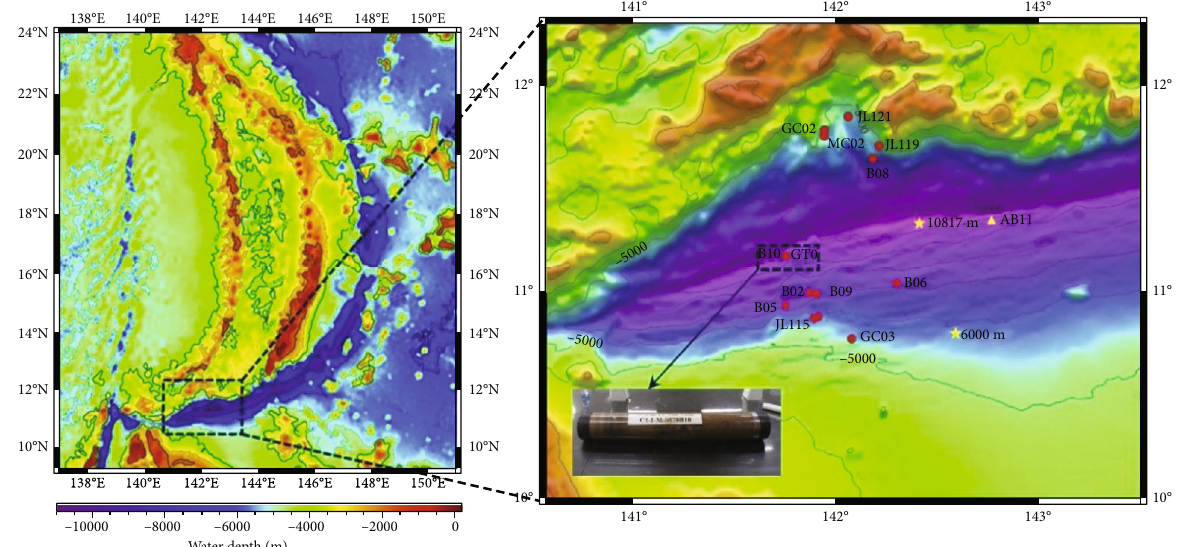
Figure 1: Bathymetric map of the southern Mariana Trench and the sampling location of this study.